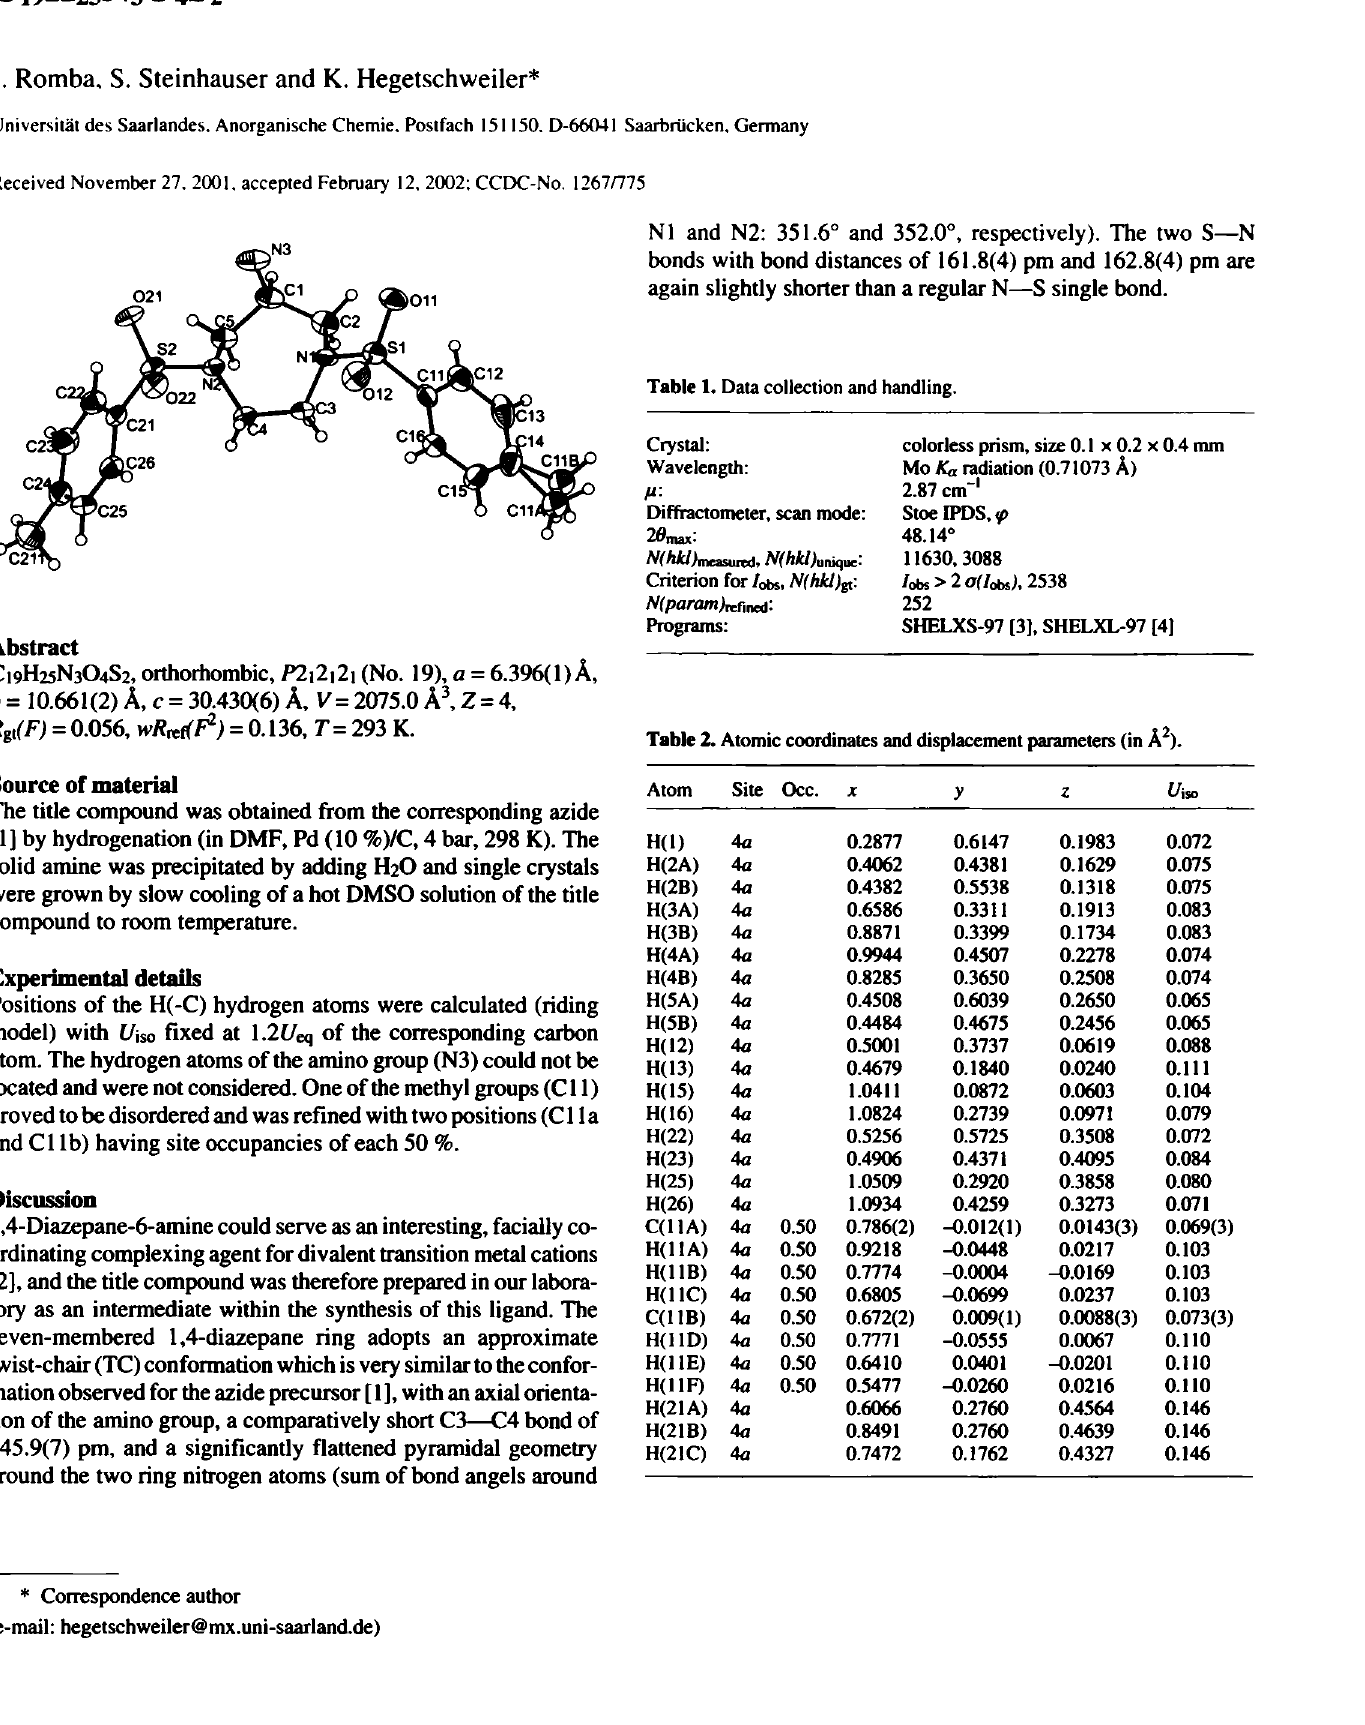
Table 1. Data collection and handling.